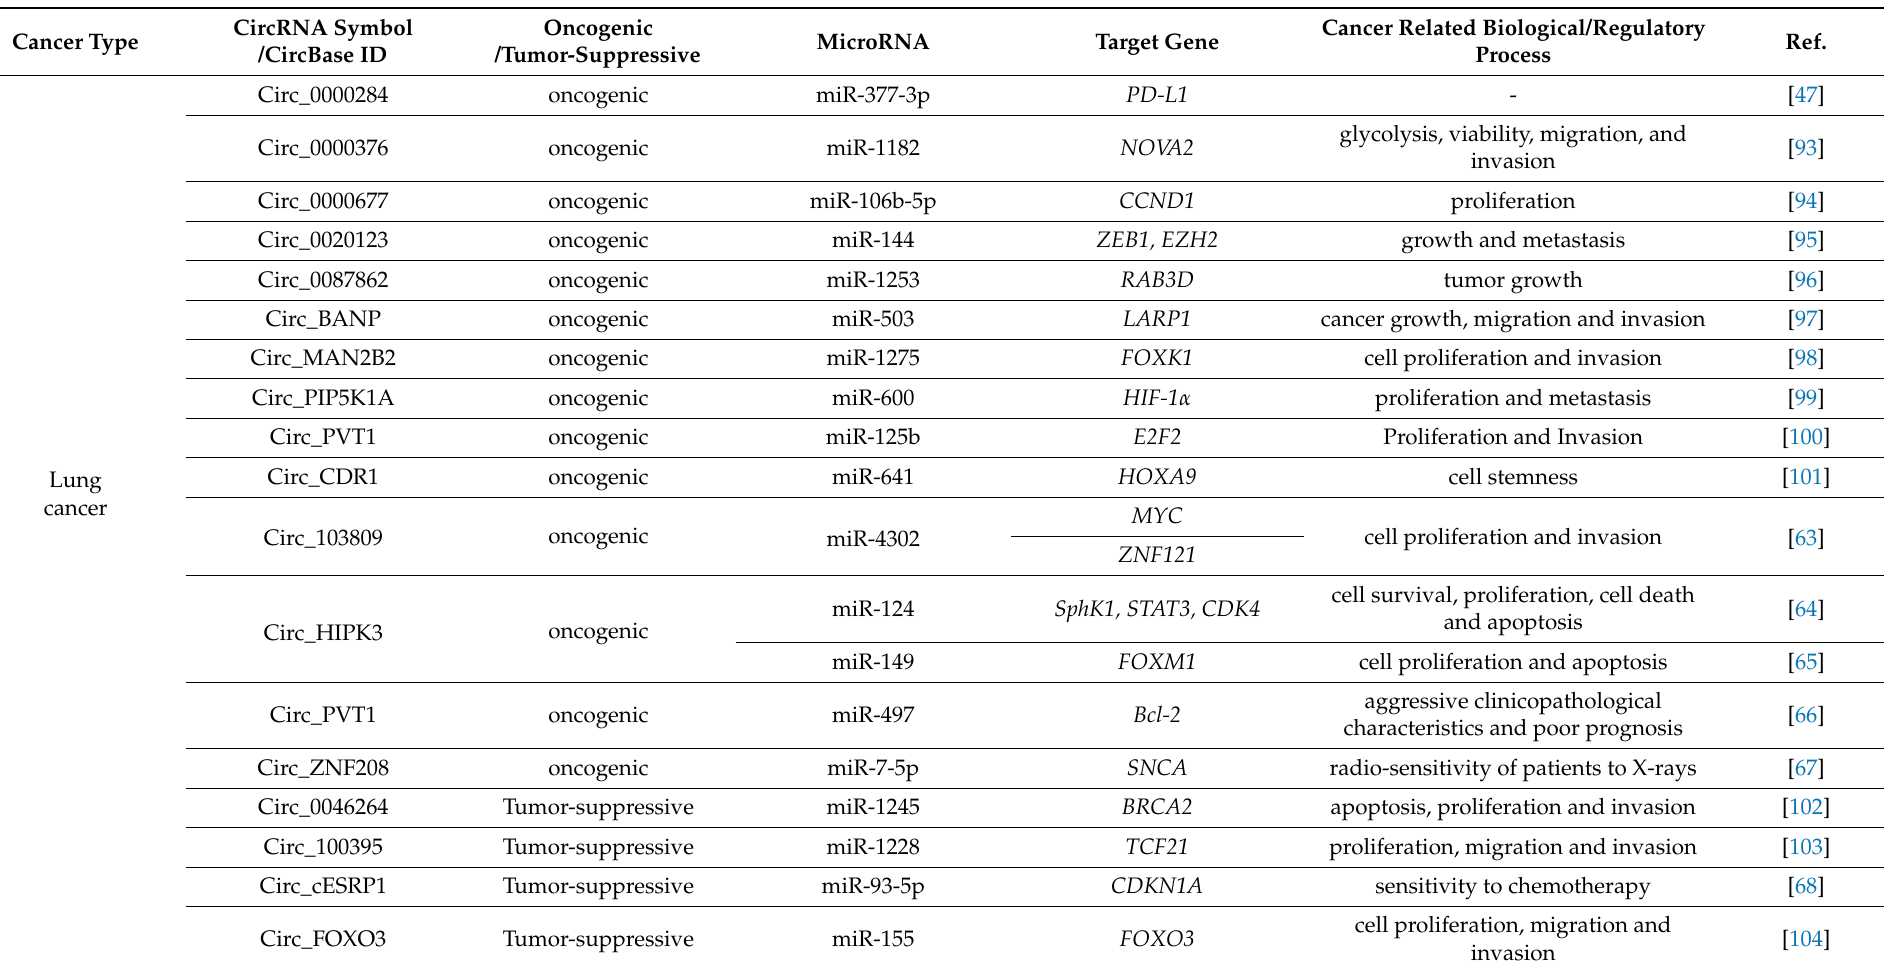
Table 1. List of differentially expressed circular RNAs and its target miRNAs in five major mortality cancers in the previous 5